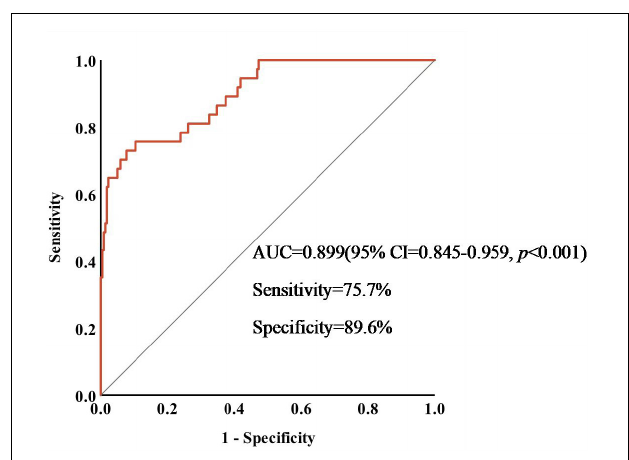
FIGURE 3 | Sensitivity and specificity of crescents in predicting the occurrence of ESKD in IgAN patients.